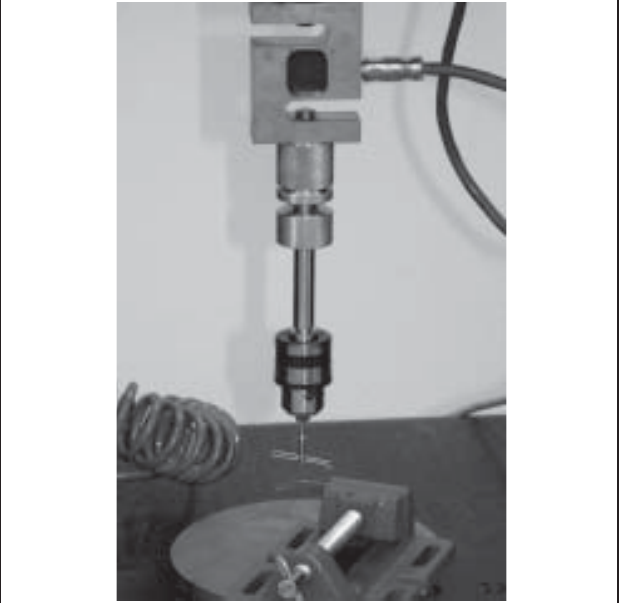
Figure 2. W-arch subjected to 12-mm compression in the EMIC DL 10000 testing